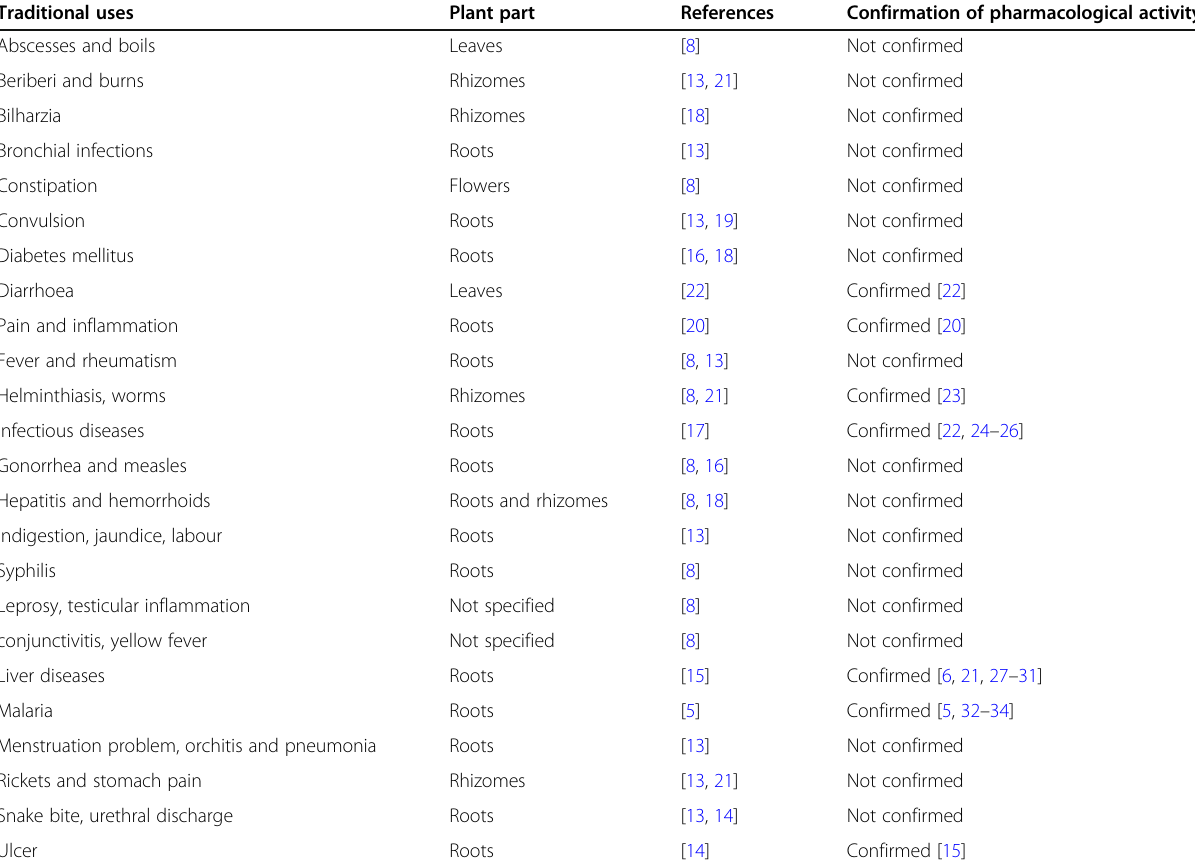
Table 1 Traditional uses of different parts of Cochlospermum tinctorium and scientific confirmation of their pharmacological activity Traditional